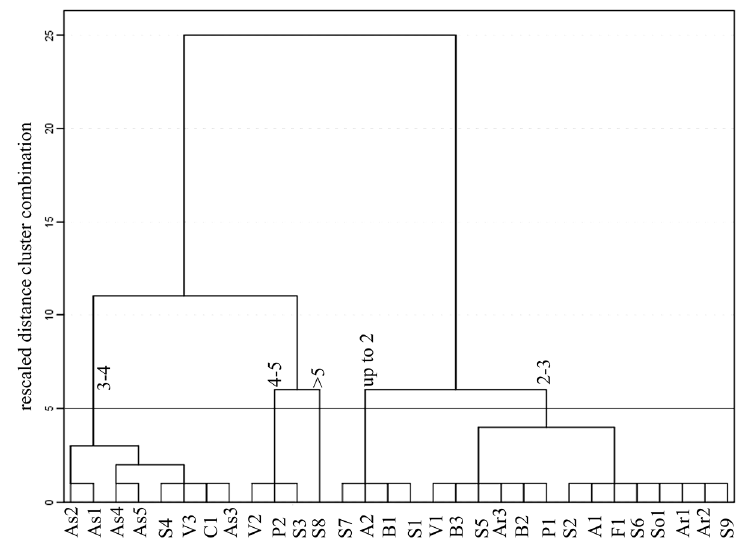
Figure 13. Dendrogram of Murata index of outcrop samples using the Ward method and the Euclidean distance as measurement range.